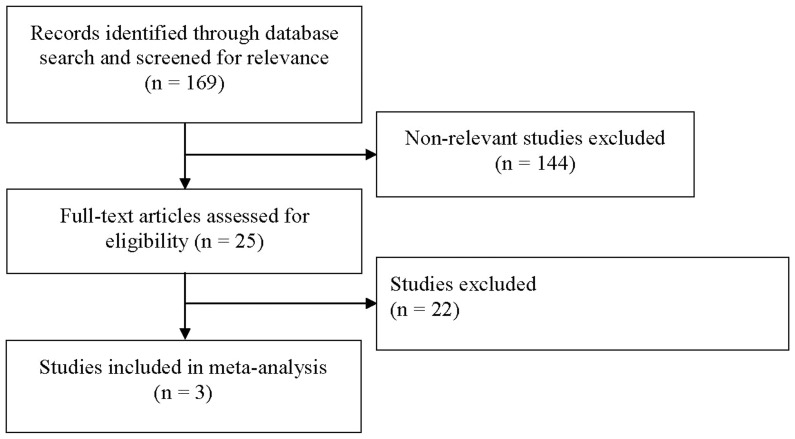
Flow diagram of study selection.